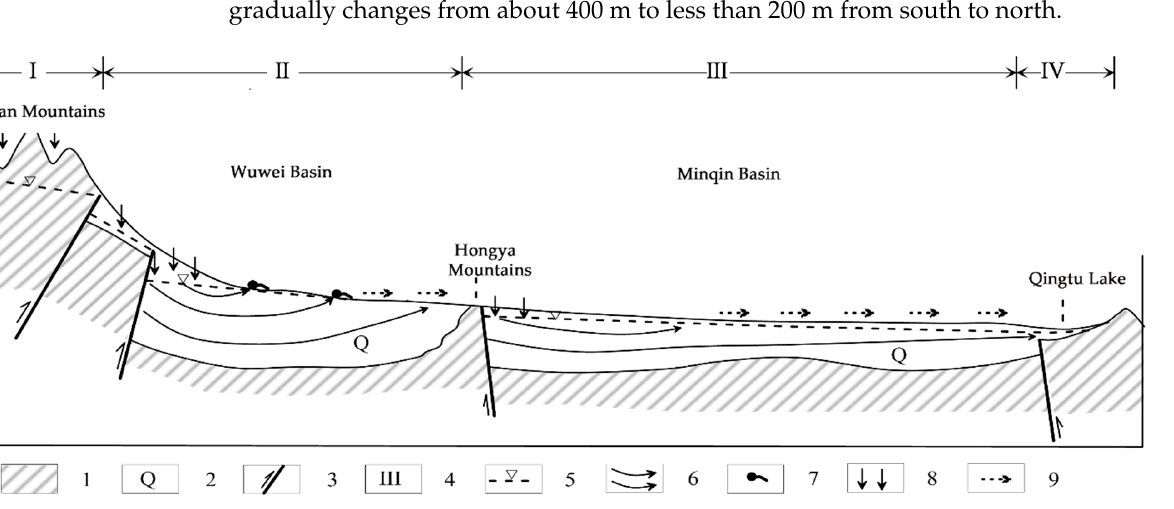
Figure 1. Water cycle patterns and ecological functions in the natural state of the Shiyang River basin. 1. Bedrock; 2. Quaternary; 3. fault; 4. water cycle transformation and GEF zoning number; 5. groundwater depth; 6. groundwater movement; 7. spring; 8. precipitation; 9. surface runoff.